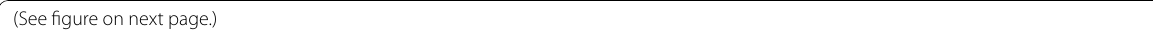
(See figure on next Fig. 1 Taphocoenosis of Jeletzkyteuthis coriacea with a smaller specimen of Parabelopeltis flexuosa , SMNS 70,623, Early Toarcian, Semicelatum to lowermost Serpentinum Zone, Ohmden, Germany. a , b photos taken with different lights. Note how morphological details appear differently in the two images. c Camera lucida drawing after b